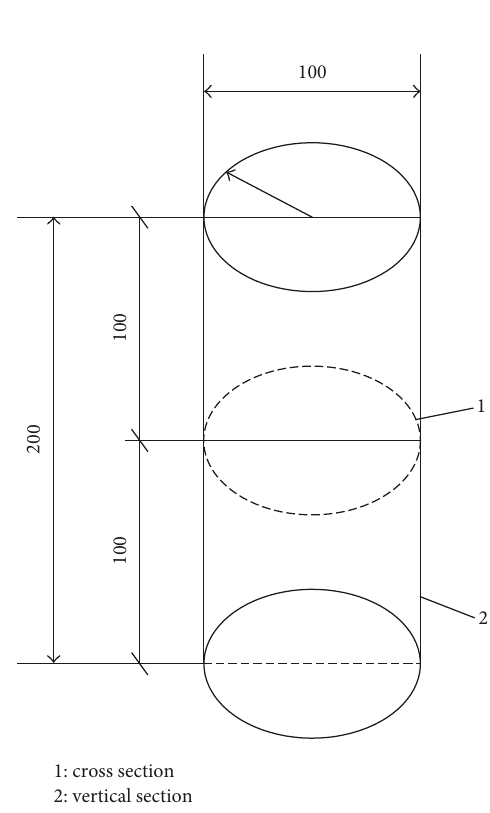
Figure 2: CT triaxial apparatus.